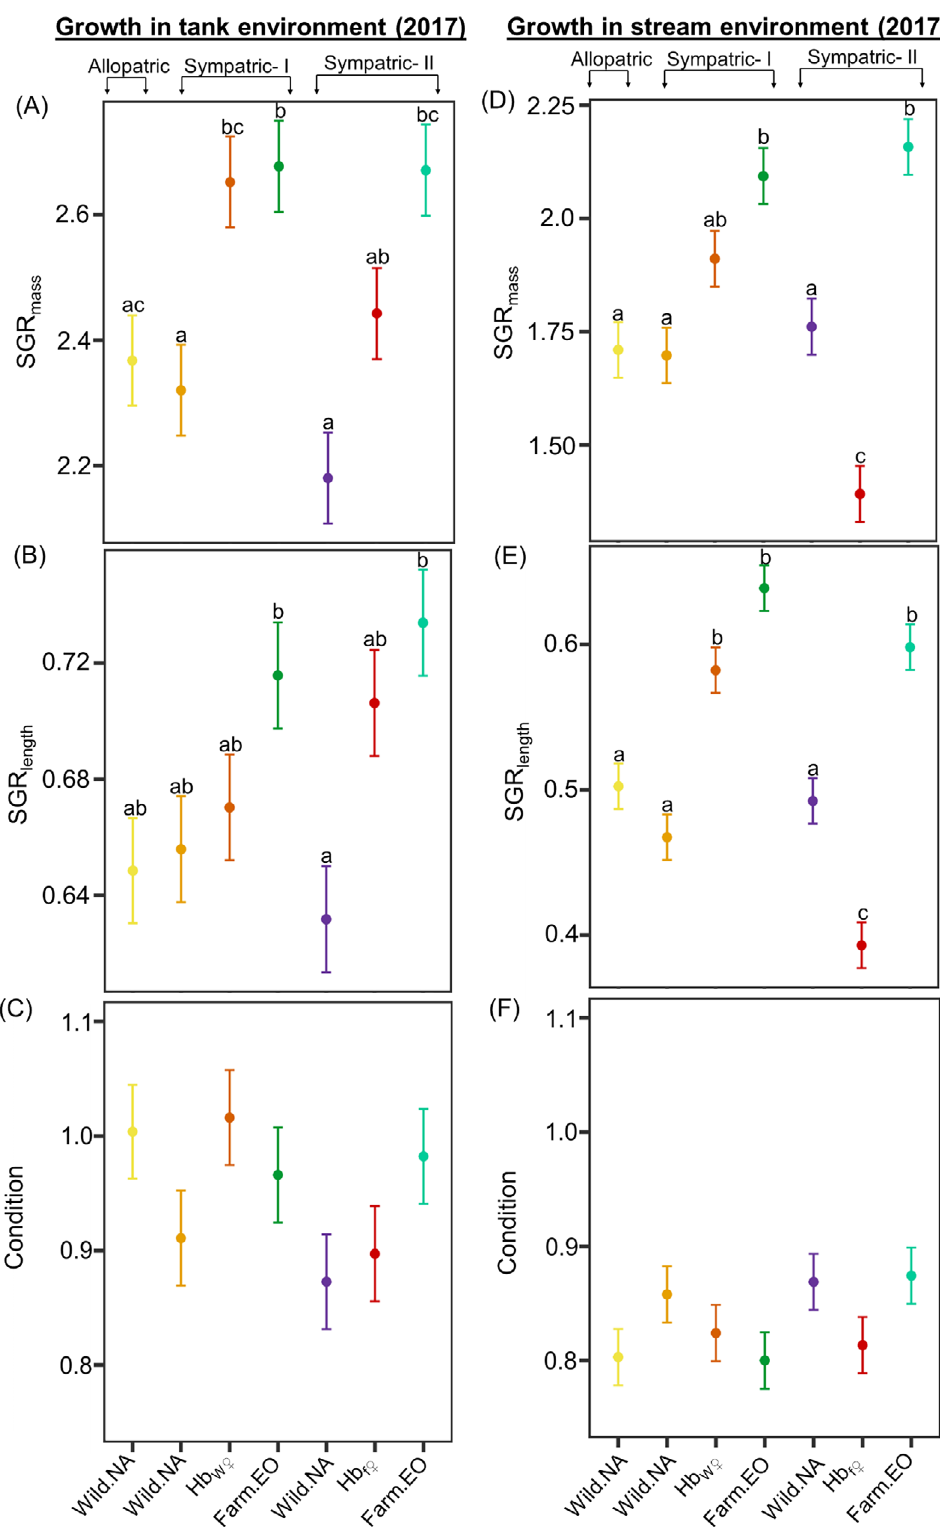
Fig. 4. (A−F) Cross type effects on Atlantic salmon growth differences in tank and stream environments (2017) using mixed- effects models. See Table S2 for estimated marginal means and Table S3 for Tukey-adjusted pairwise contrasts among cross types fitted in the final models. See Fig. 2 for cross